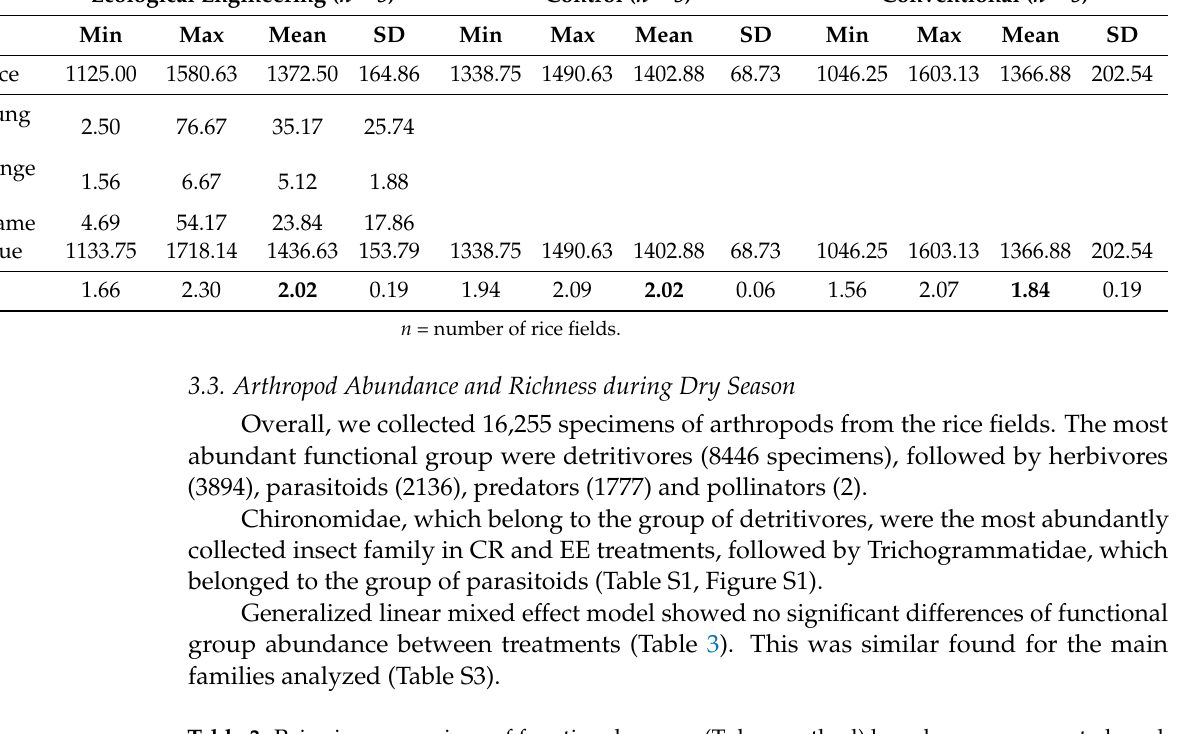
Table 3. Pairwise comparison of functional groups (Tukey method) based on our computed mod- els of functional group abundance collected in different treatments (CR = conventional rice field; EE = ecologically engineered field; control) during the dry (DS) and wet season